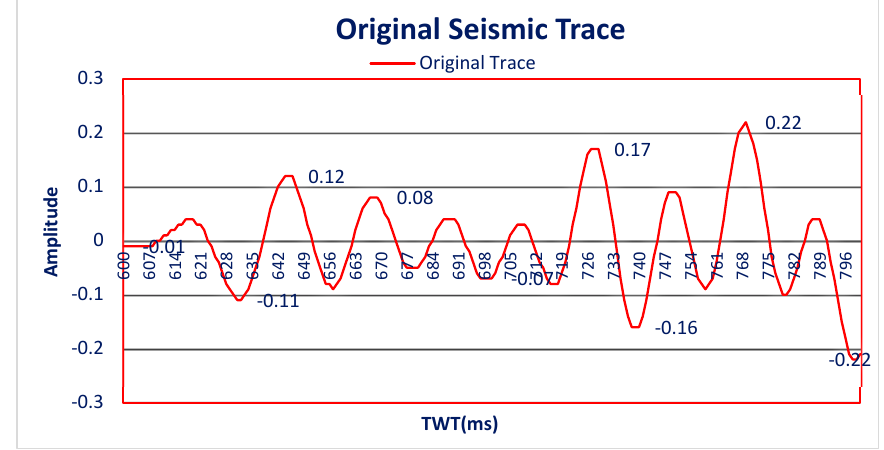
Figure 11. a plot of the original model parameter. A basis pursuit decomposition algorithm was applied to the modeled trace to decom- pose it into a superposition of layer spectra [17], and the emerging components were summed up using Equation (10) to obtain the band expanded trace shown in Figure 12 below. The result shows an improved resolution while also maintaining the characteristics of the original trace. It is observed that the seismic amplitude is reduced significantly across the time series. For instance, the maximum positive amplitude dropped from +0.2 to +0.053 while the maximum negative amplitude increased from − 0.2 to − 0.068. To correct for the amplitude difference, a global factor was applied by multiplying the amplitude by a constant, and the result is as shown in Figure 13 below, which is an overlay of both traces. Both traces compare very well, while the enhanced trace also maintains a very good resolution.